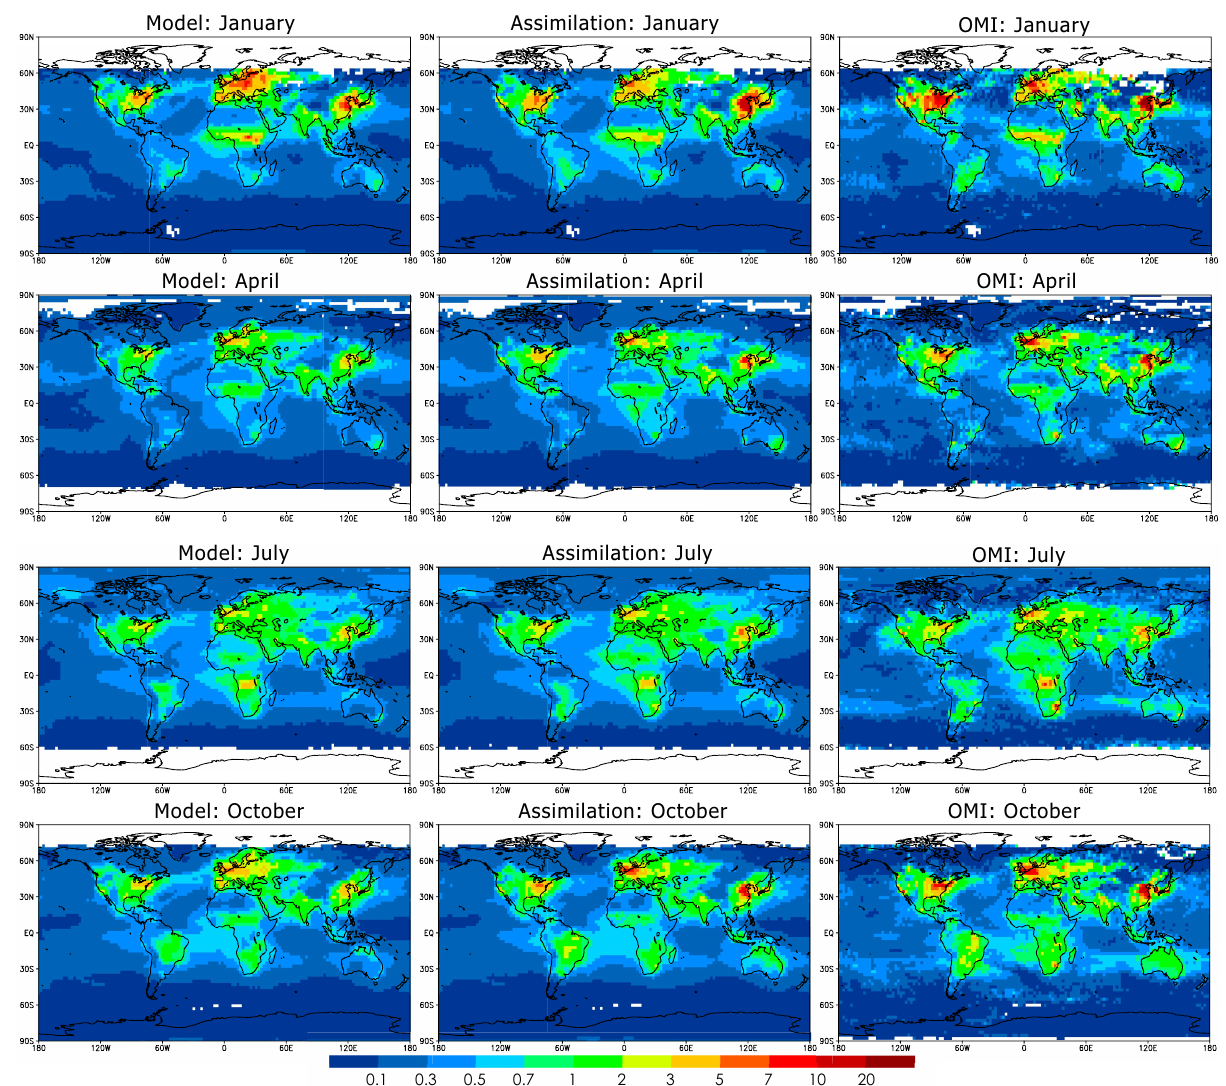
Fig. 9. Global distributions of the tropospheric NO 2 columns (in 10 15 molec . cm − 2 ), averaged over the 16–30th of each month, obtained from the CHASER simulation (w/o data assimilation, left columns), the data assimilation run (center columns), and DOMINO v2 (right columns) in January, April, July, and October 2005. The red (blue) colour indicates relatively high (low)